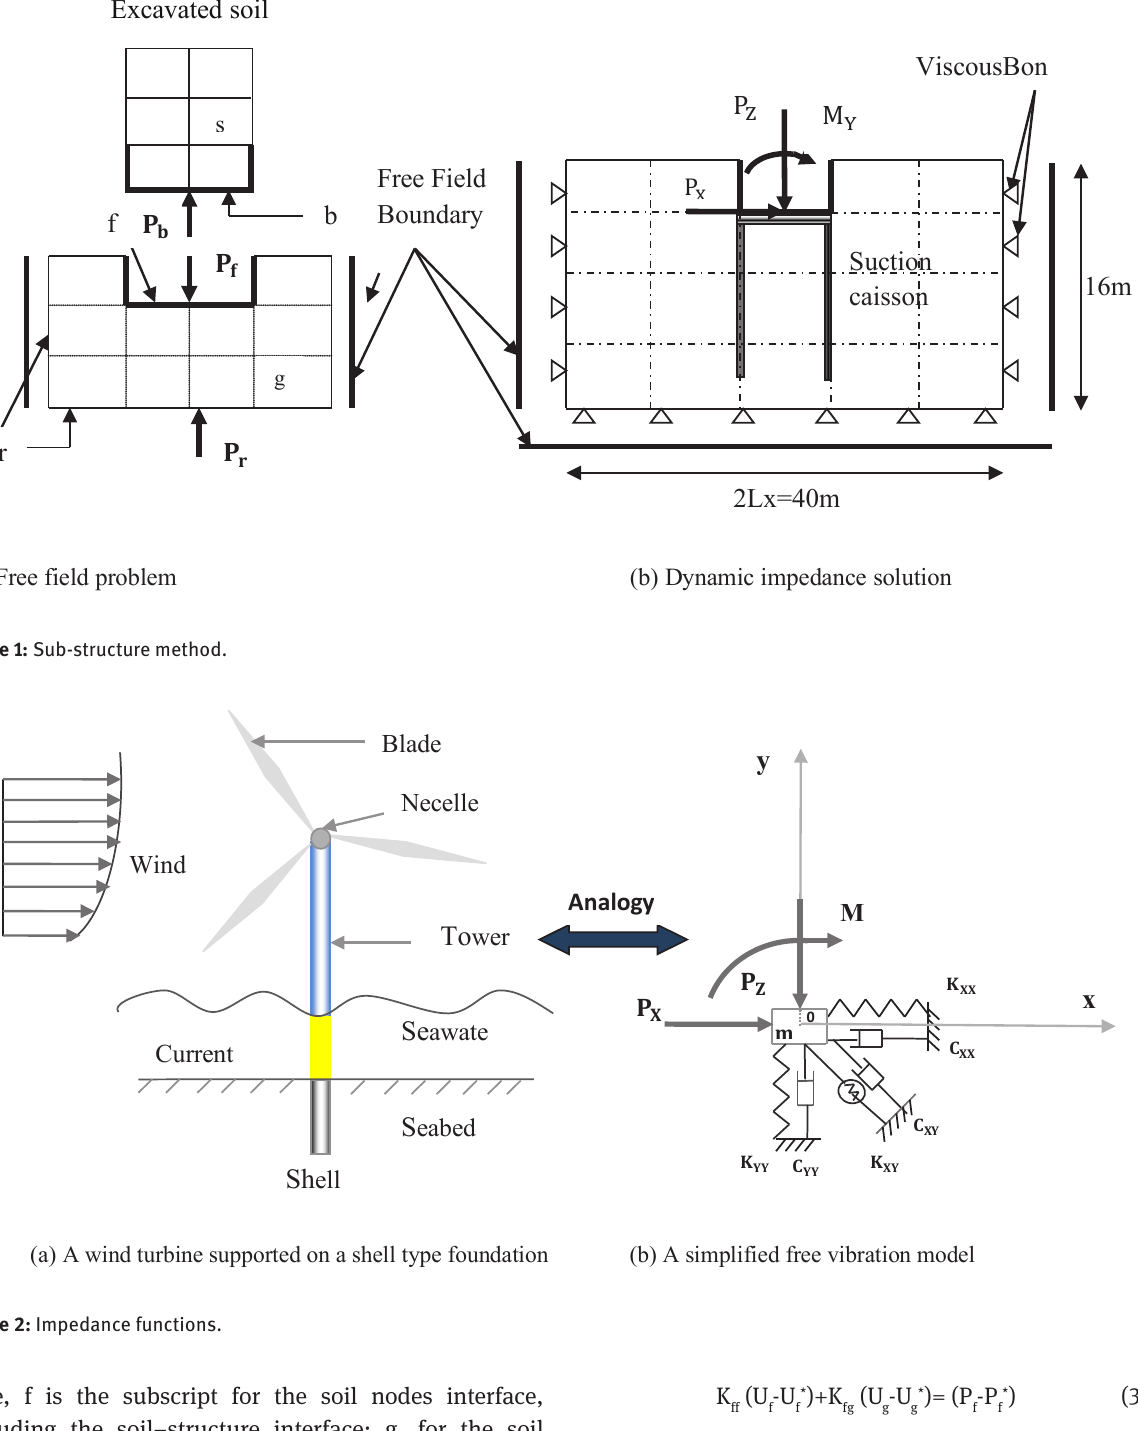
Figure 2 Impedance functions